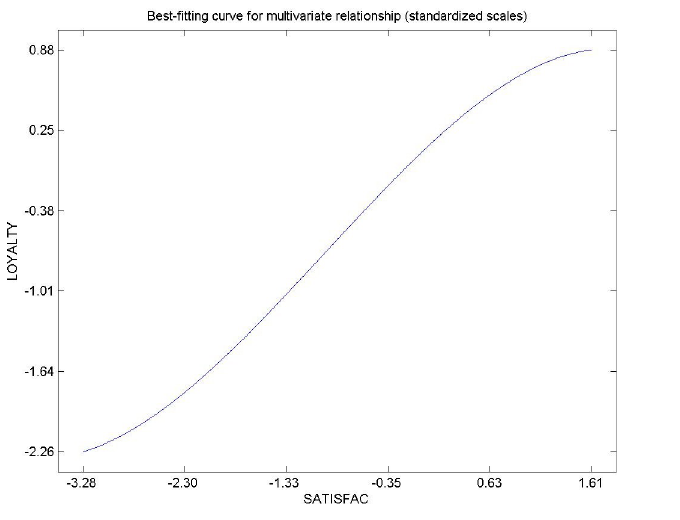
Fig 13. Hypothesis 11,